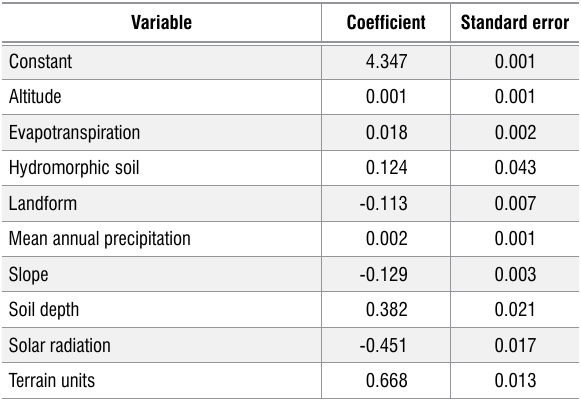
Table 3: Coefficients and standard errors for variables used in the logistic regression model